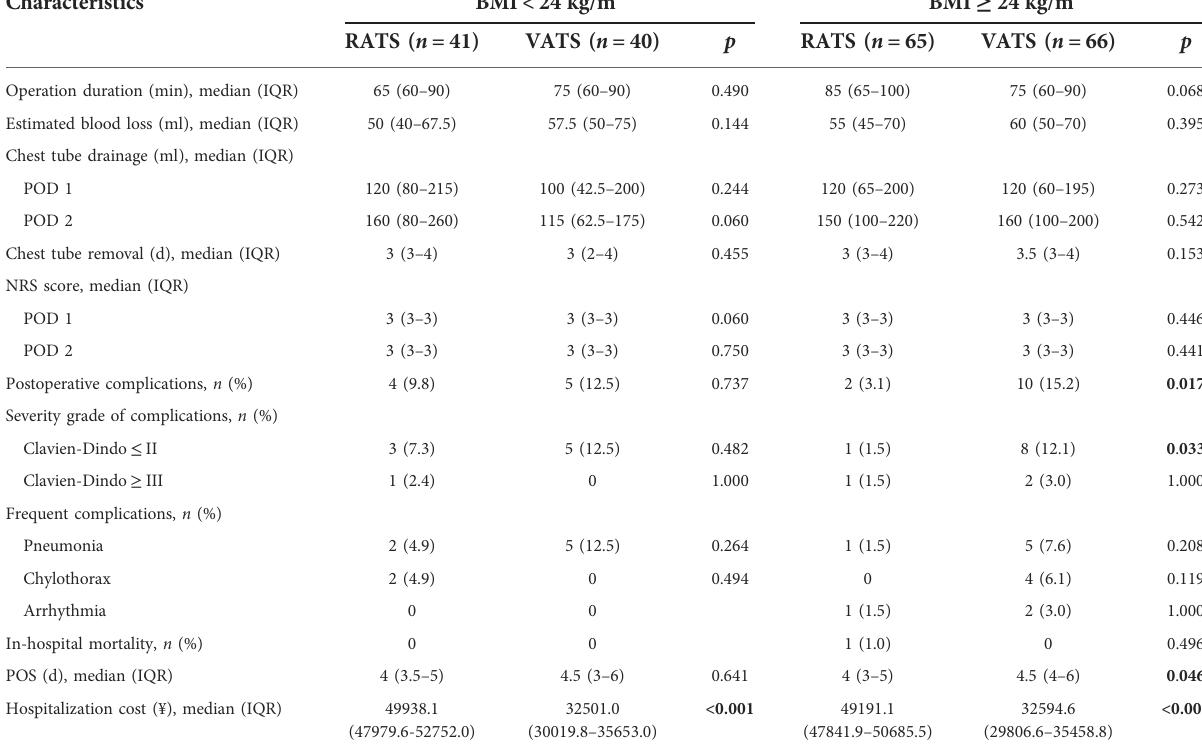
TABLE 3 Perioperative outcomes of VATS and RATS for mediastinal masses in patients with different BMI ranges.